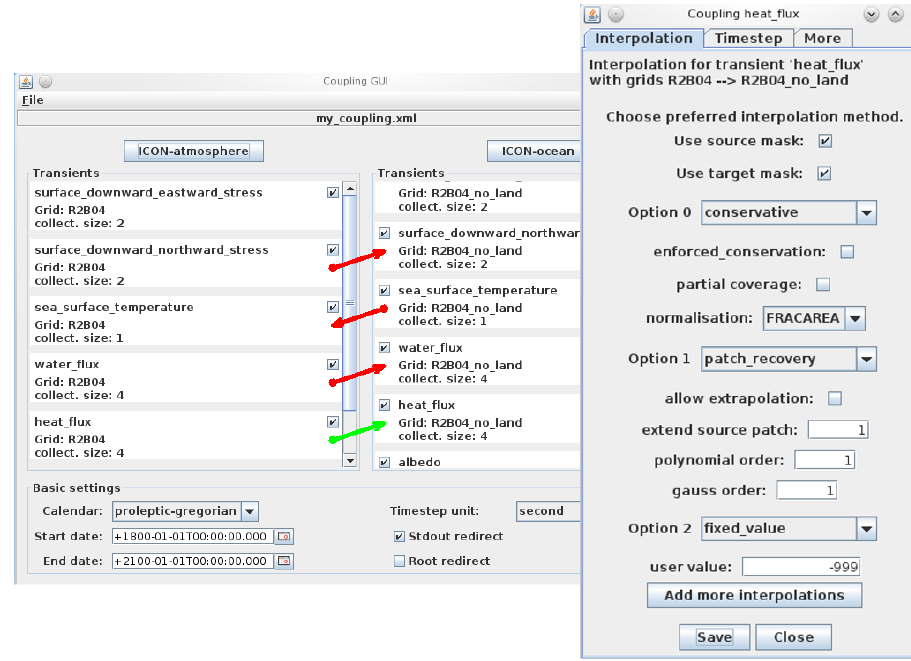
Figure A1. Coupling GUI with detail